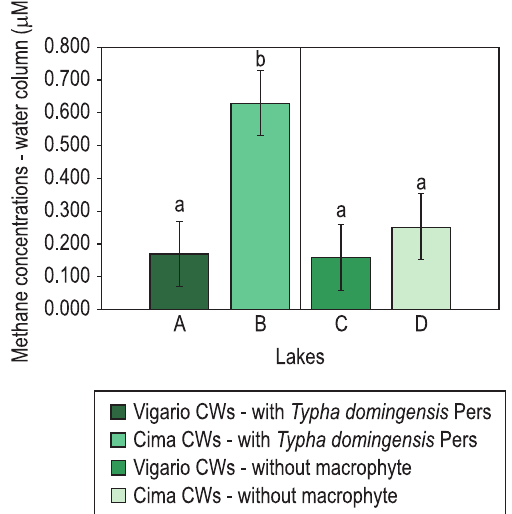
Figure 2. CH concentrations in waters of eutrophic 4 (Lake Vigário) and mesotrophic (Lake Cima) CW`s with and without macrophyte. a) Lake Vigário CWs with macrophyte Typha domingensis Pers ; b) Lake Vigário CWs without macrophyte; c) Lake Cima CWs with Typha domingensis Pers ; and d) Lake Cima unplanted plots. Distinct letters ( a,b ) show significant differences among treatments, for each lake separately (Kruskal-wallis test (95% s level of significance) and Dunn´s test (95% of level of